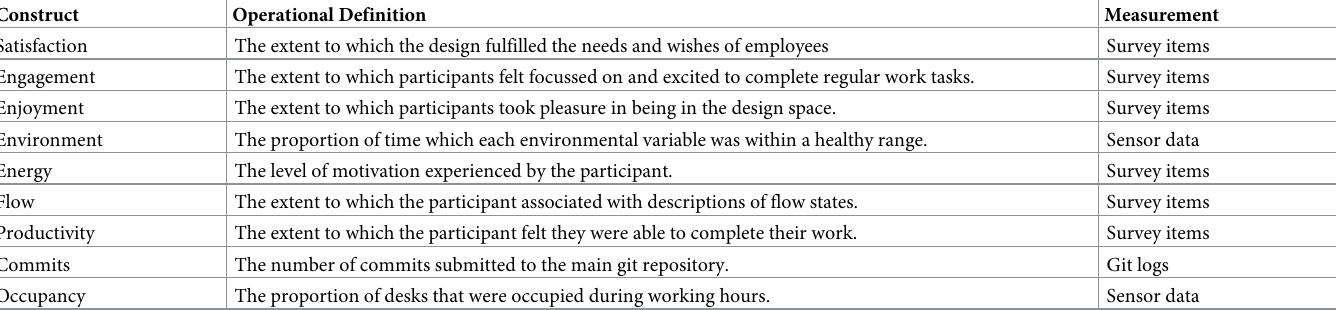
Table 2. Definitions and measurements of constructs considered in the